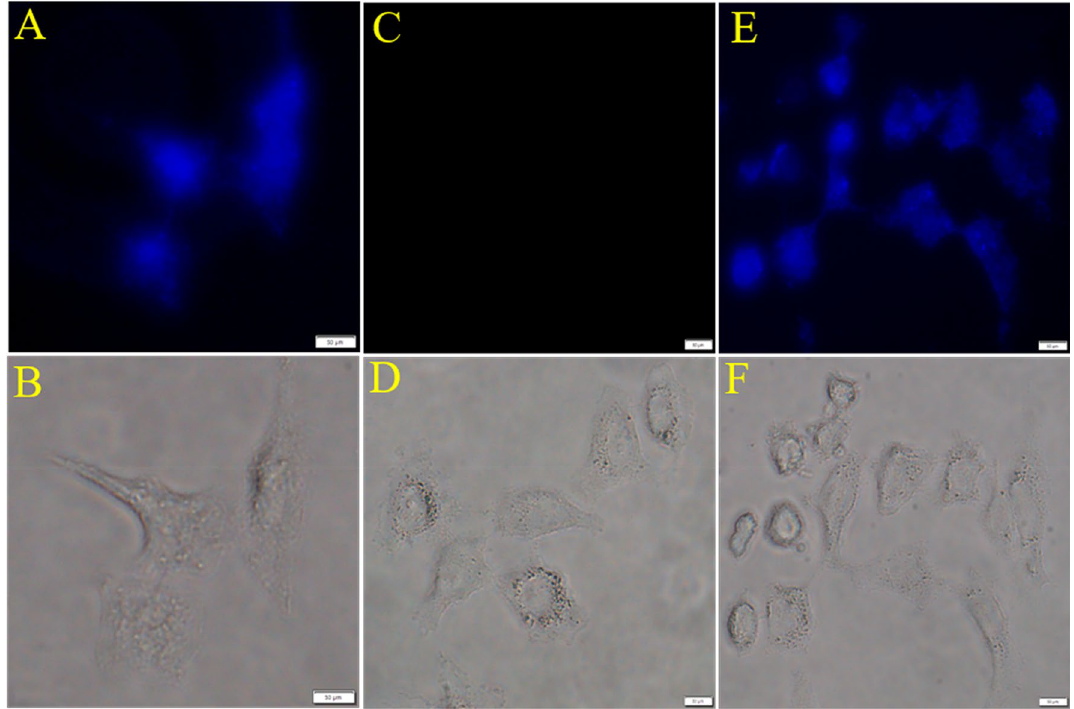
Figure 4.. Fluorescence microscopic images of HUH-7 cells treated with N-CQDs, Co 2+ and DCA ( A ) cell treated with N-CQDs at concentration 10 µg/ml ( B ) phase contrast images of ( A ). ( C ) Cell treated with N-CQDs + Co 2+ at concentration 10 µg +10 µg/ml ( D ) phase contrast images of ( C ). ( E ) Cell treated with N-CQDs + Co 2+ + DCA at concentration 10 µg+10 µg+20 µM. ( F ) phase contrast images of ( E ). All images are acquired with 20x objective lens with applied wavelength λex = 340 nm, λem = 459 nm filter used